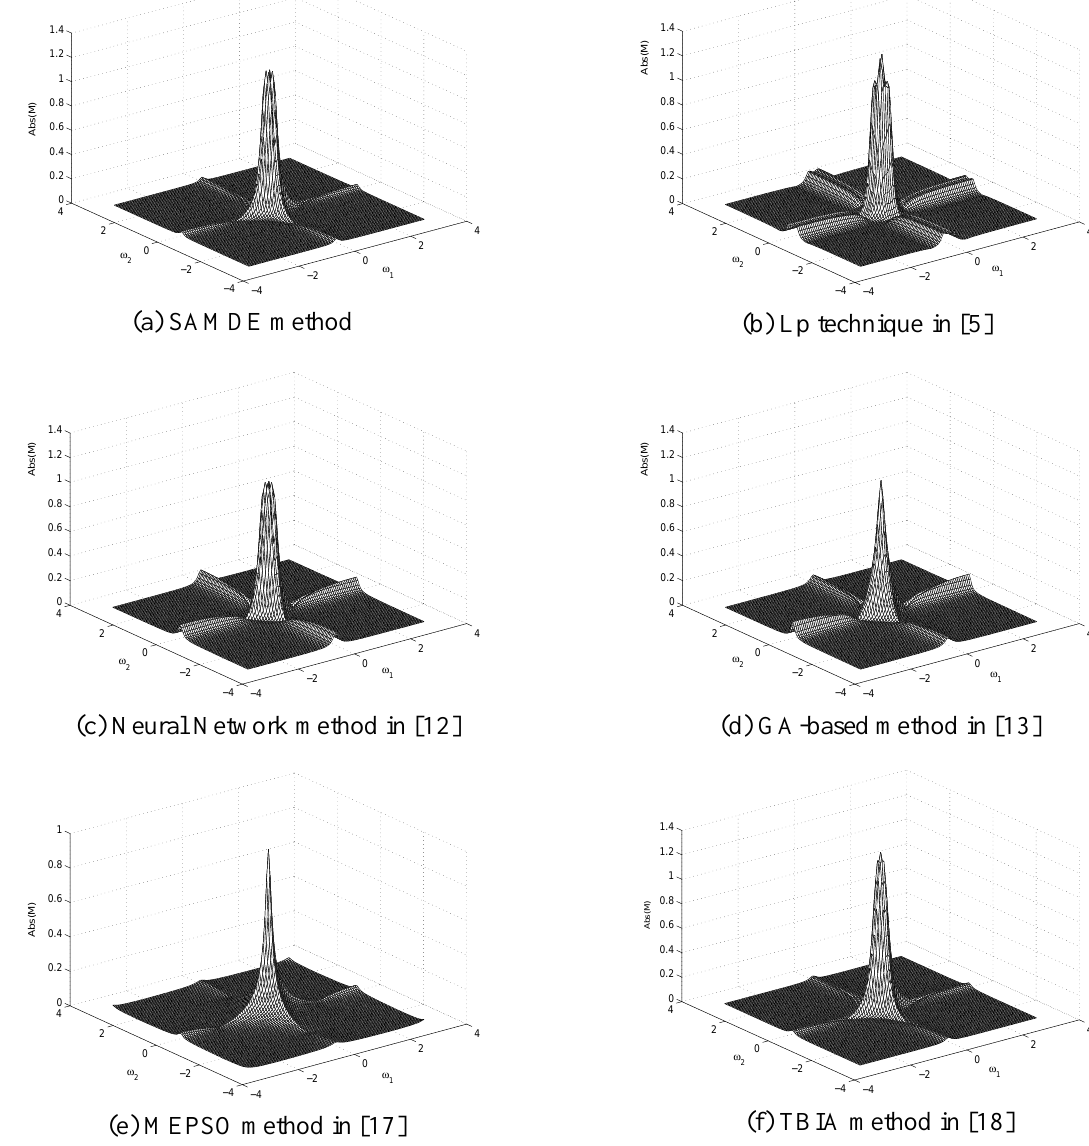
Fig. 3. Comparison of the amplitude response | M ( ω 1 , ω 2 ) | of the considered 2-D